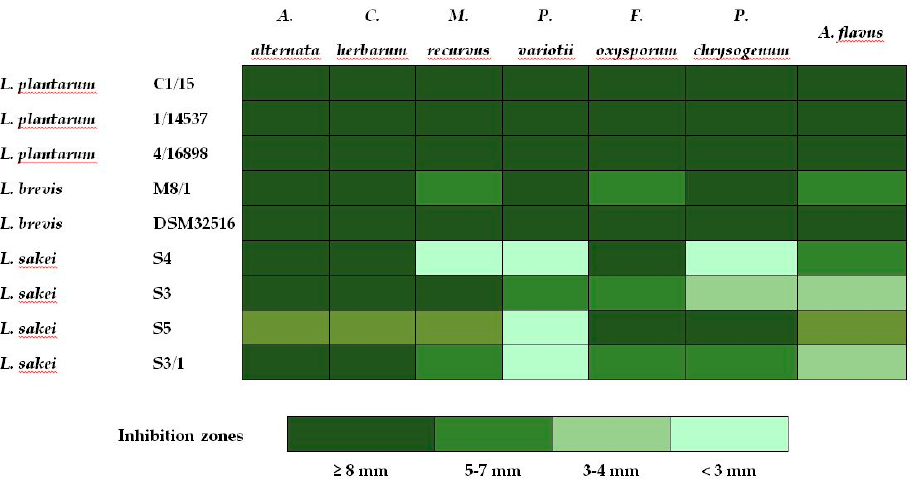
Figure 3. Antifungal activity of Lactobacillus strains: inhibition zones against A. alternata , C. herbarum , M. recurvus , P. variotii , F. oxysporum , A. flavus ATCC 46283, P. chrysogenum ATCC 9179.